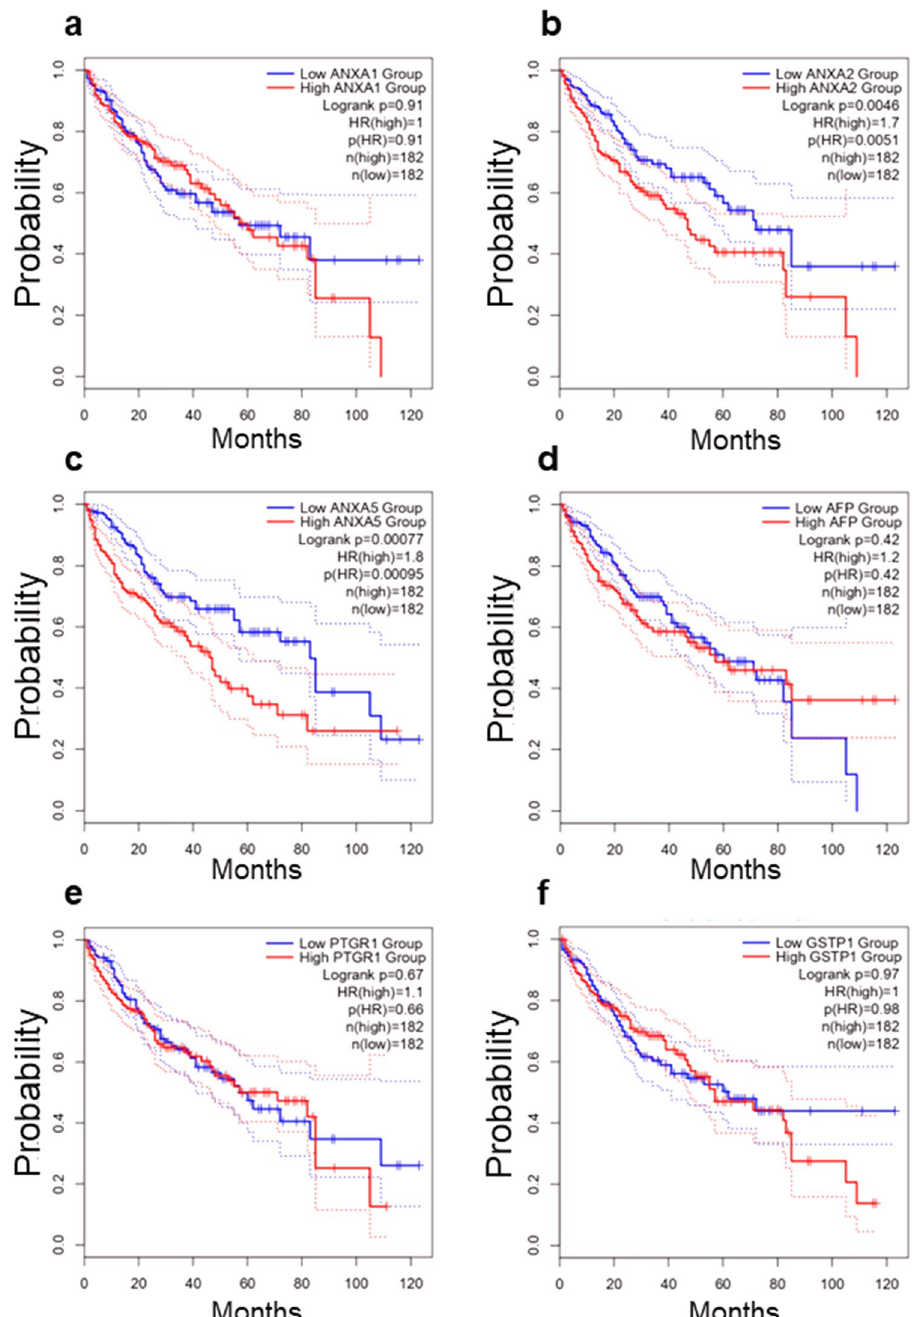
Figure 6. Kaplan–Meier curves for overall survival (OS). Plots show the percent of 5-year overall survival associated with the expression levels of ANXA1 ( a ), ANXA2 ( b ), ANXA5 ( c ), AFP ( d ), PTGR1 ( e ), and GSTP1 ( f ) in HCC patients. Data were obtained from the liver hepatocellular carcinoma (LIHC) project, which comprises data from 364 HCC primary tumors, (https:// portal. gdc. cancer. gov/ proje cts/ TCGA-